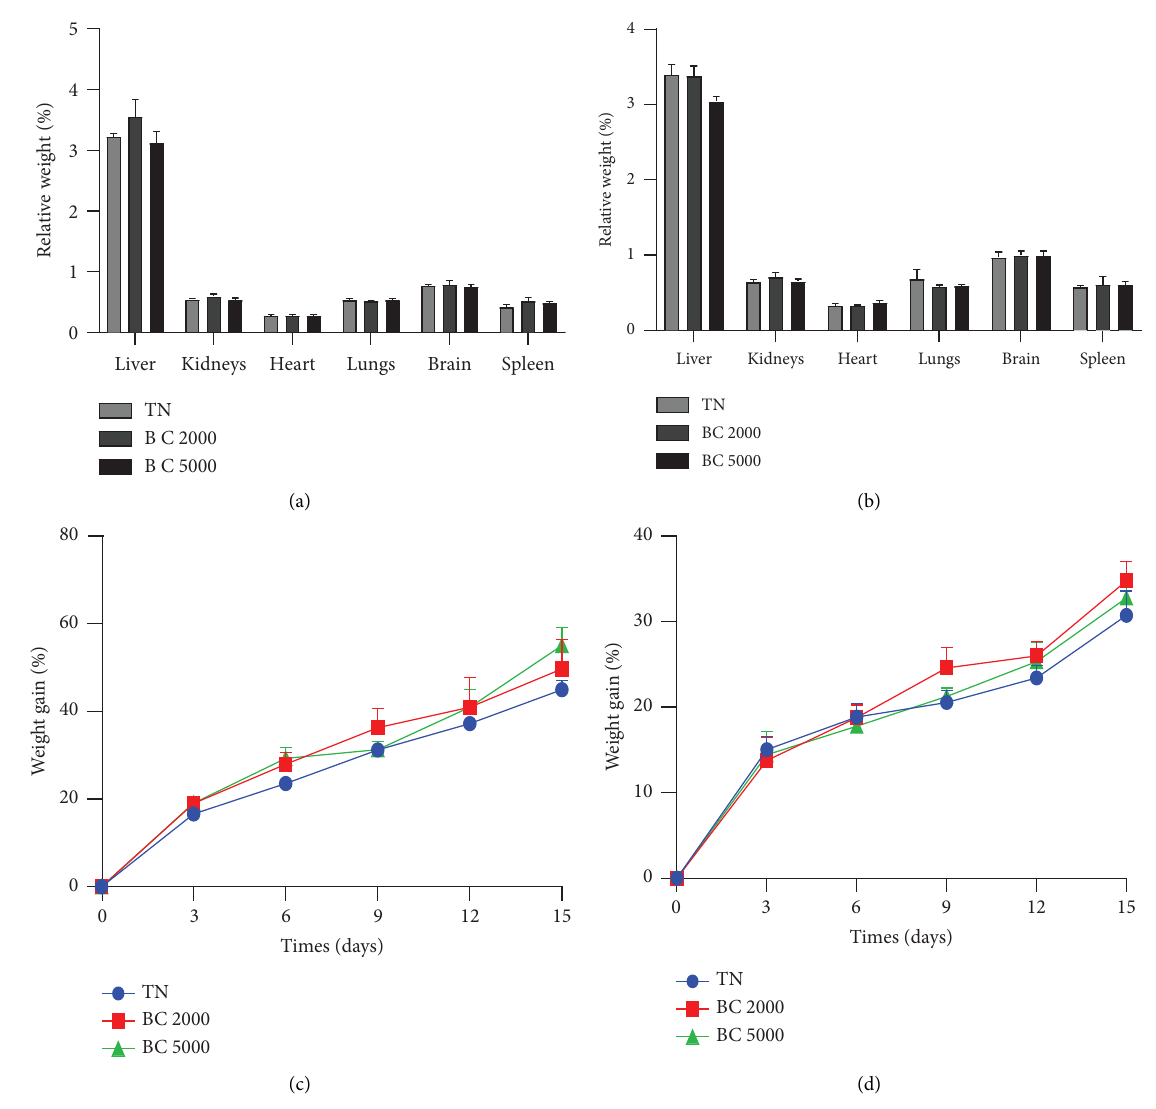
Figure 1: Efects of the plant mixture aqueous extract on the relative organ weight of male (a) and female rats (b) and on the weight gain evolution of male (c) and female (d) rats in acute toxicity. Each bar and point represent the mean ± SEM, n � 3; TN � normal rats receiving distilled water (10 mL/kg); BC 2000 and BC 5000 � normal rats treated with the aqueous extract of the mixture of B. pilosa and C. citratus at doses of 2000 and